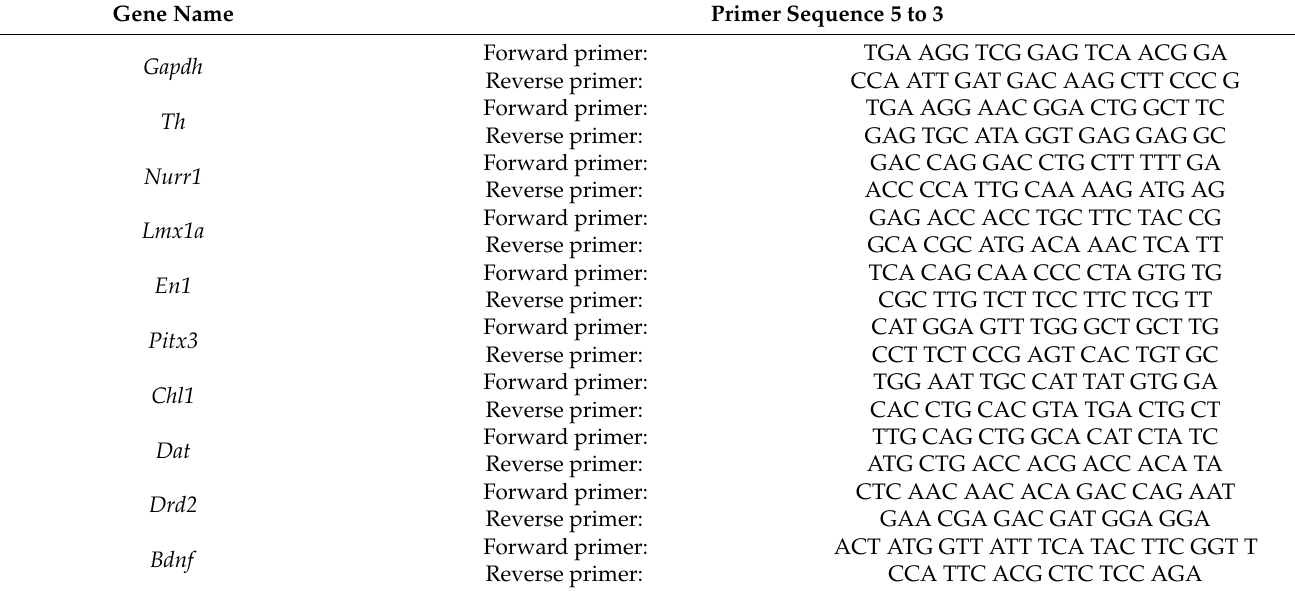
Table 1 lists the primer sequences used for the selected genes. Table 1. Sequences for the gene-specific primer pairs used in